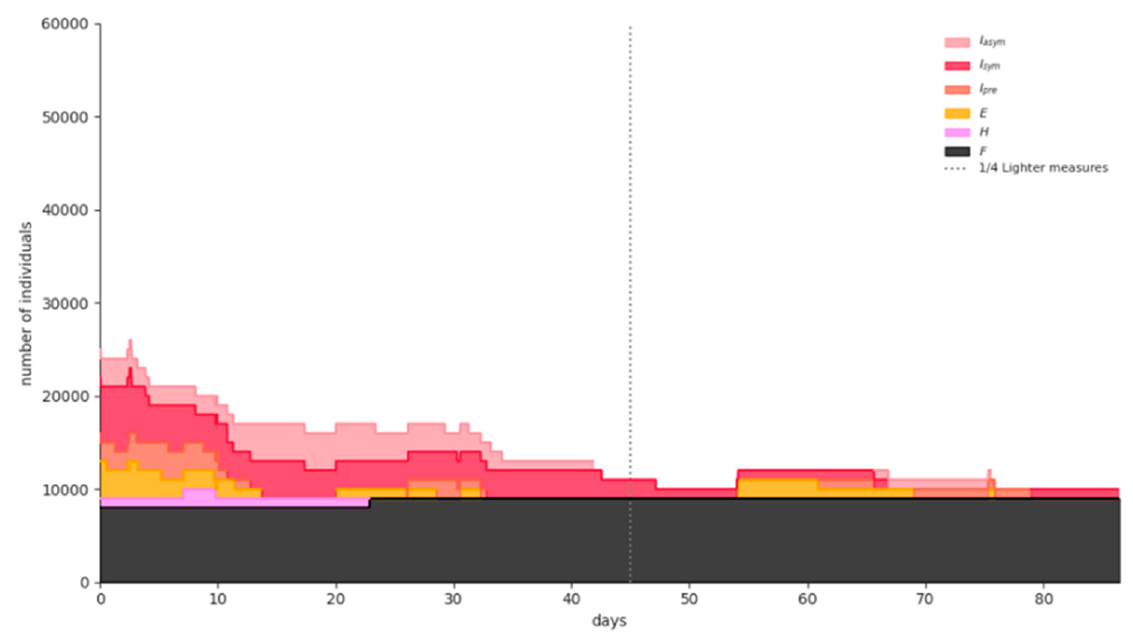
Figure 9. Simulation results for a representative phase-2 scenario